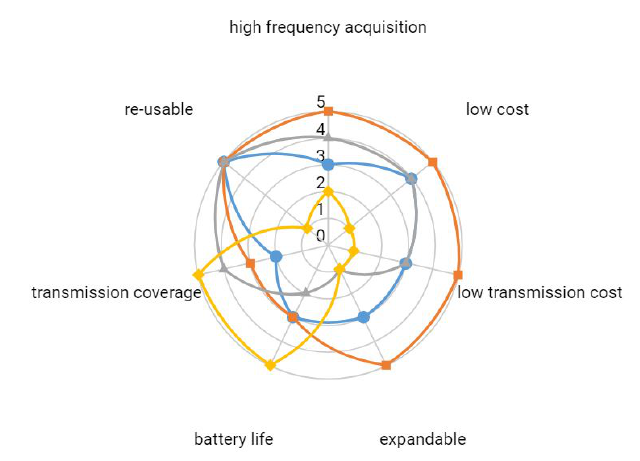
Figure 10. Comparison of transmissions technologies for drifters: GSM, LoRa, SPOT,